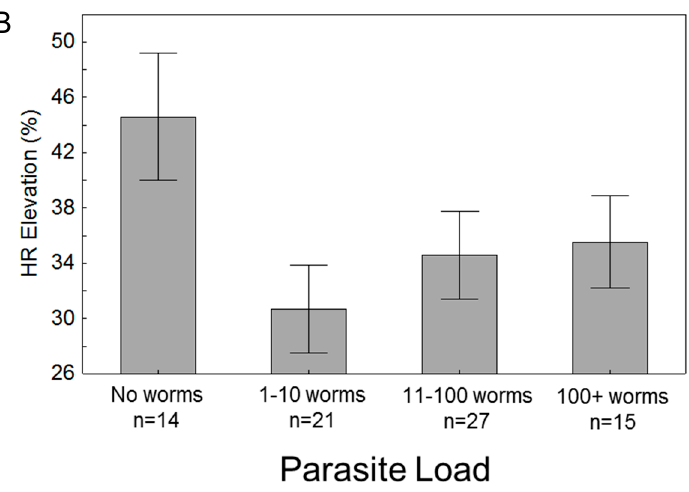
Figure 4. Comparison of ( A ) baseline and ( B ) stressed heartrates of beetles across parasite intensity groupings (see 2.5 Parasite Assessment) in the second experiment ( n = 77 wild beetles). Whiskers represent standard errors of the means.